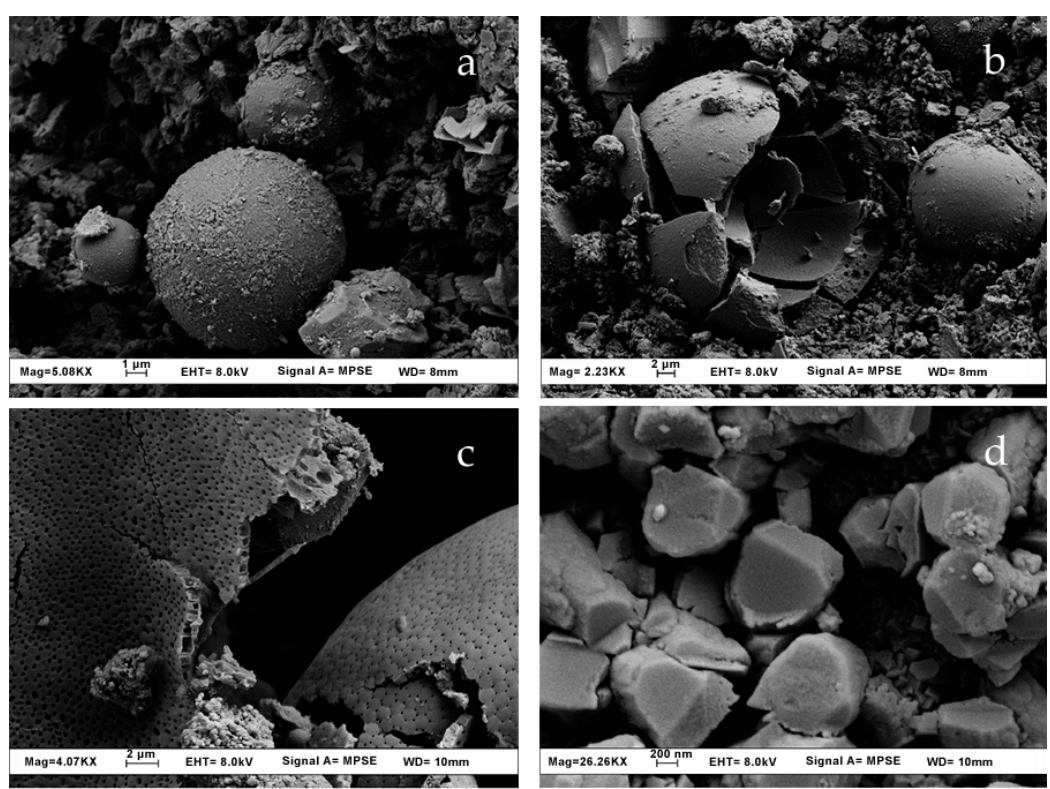
Figure 5. SEM images of RSPRC. The magnifications from ( a – d ) are 5080, 2230, 4070, 26260.